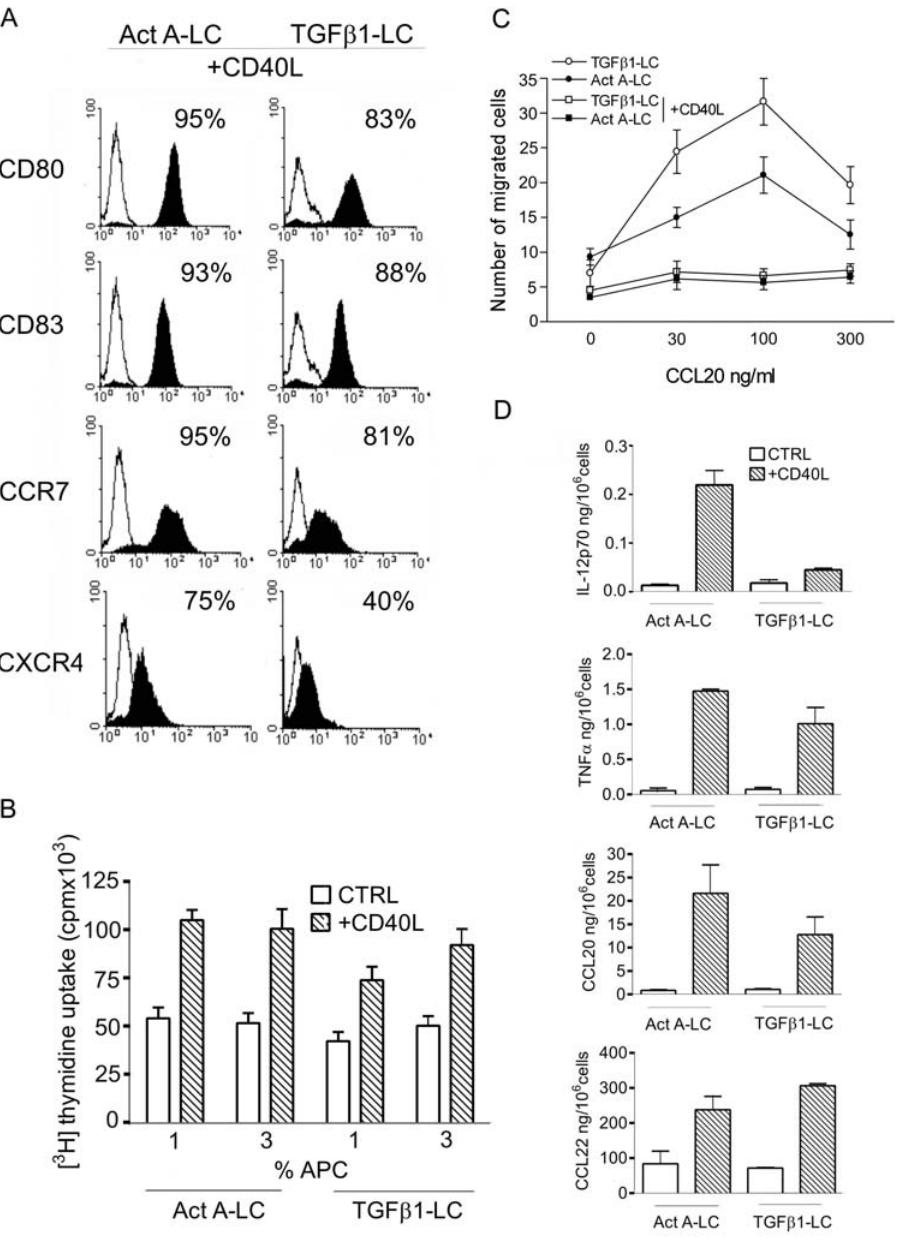
Figure 2. Phenotypical and functional characterization of CD40L-activated Act A-LC (A) Expression of maturation markers by Act A-LC. Act A-LC were incubated with CD40L-transfected fibroblasts for 40 hrs and stained with anti-CD80, CD83, CCR7 and CXCR4 moAbs (filled histograms) or isotype-matched negative control Abs (open histograms). Results obtained with TGF b 1-LC are also shown for comparison. The percentage of positive cells is reported in each panel. Data shown are representative of three independent experiments. (B) Allostimulatory capacity of Act A-LC. Irradiated immature or CD40L-matured Act A-LC (or TGF b 1-LC) were cultured with 2 6 10 5 allogeneic purified T cells. Proliferation was assayed as uptake of [H 3 ]thymidine added in the last 16 hrs of a 6-day culture assay. Results are expressed as mean counts per minute (cpm) 6 SD of one representative experiment performed in triplicate. Values are at the net of T cell proliferation in the absence of DC (3250 6 250 cpm). (C) Act A-LC migrate in response to CCL20. Immature or CD40L-mature Act A-LC or TGF b 1-LC were applied to the upper wells of the chemotaxis chamber. CCL20 was added to the lower level of the chamber. The number of cells migrated to the lower chamber was counted. Each assay was performed in triplicate and the results are expressed as the mean 6 SD number of migrated cells (representative of three experiments). (D) Cytokine release by Act A-LC. Immature or CD40L-mature Act A-LC or TGF b 1-LC were assessed for their ability to release the indicated cytokines by ELISA. Results are the average determination ( 6 SD) of four independent experiments.